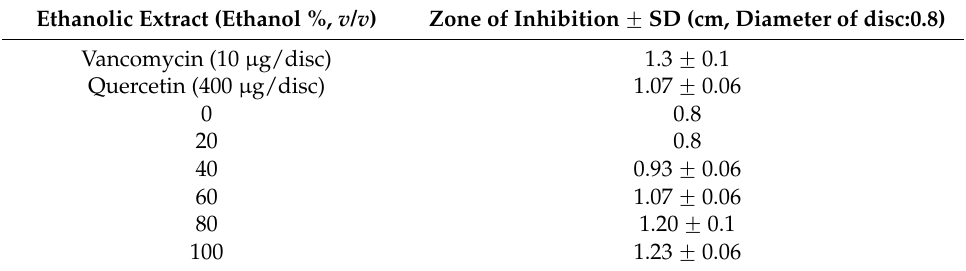
Table 5. Antimicrobial activity of extract from C. coreana Uyeki flos.